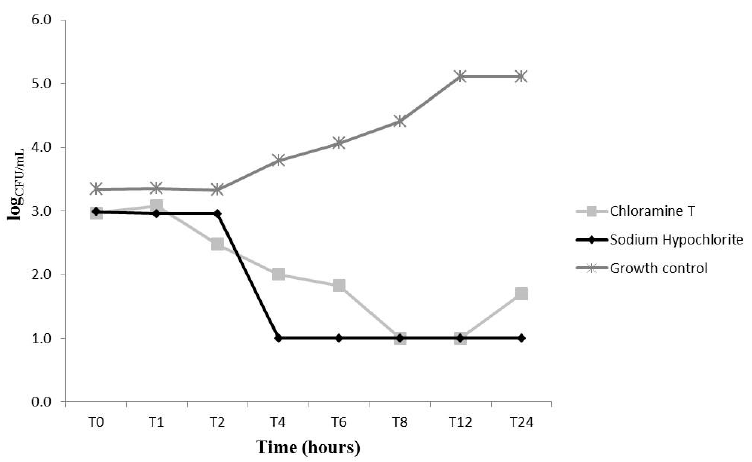
Figure 3. Candida albicans ATCC 60193 fungal growth kinetics upon treatment with chloramine T (5.54 mmol/L) and sodium hypochlorite (16.79 mmol/L) at 2 times their MIC concentrations.